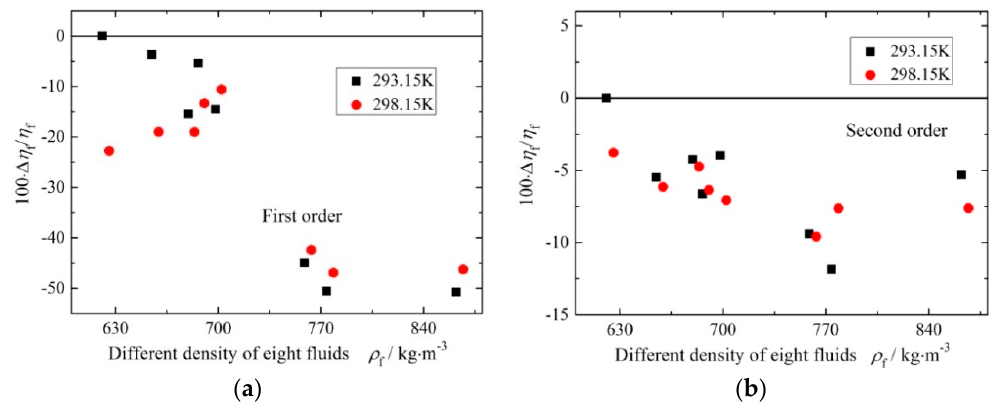
Figure 12. Relative errors of viscosity under different order modes. ( a ) Under first order mode (flexure); ( b ) under second order mode (torsion).